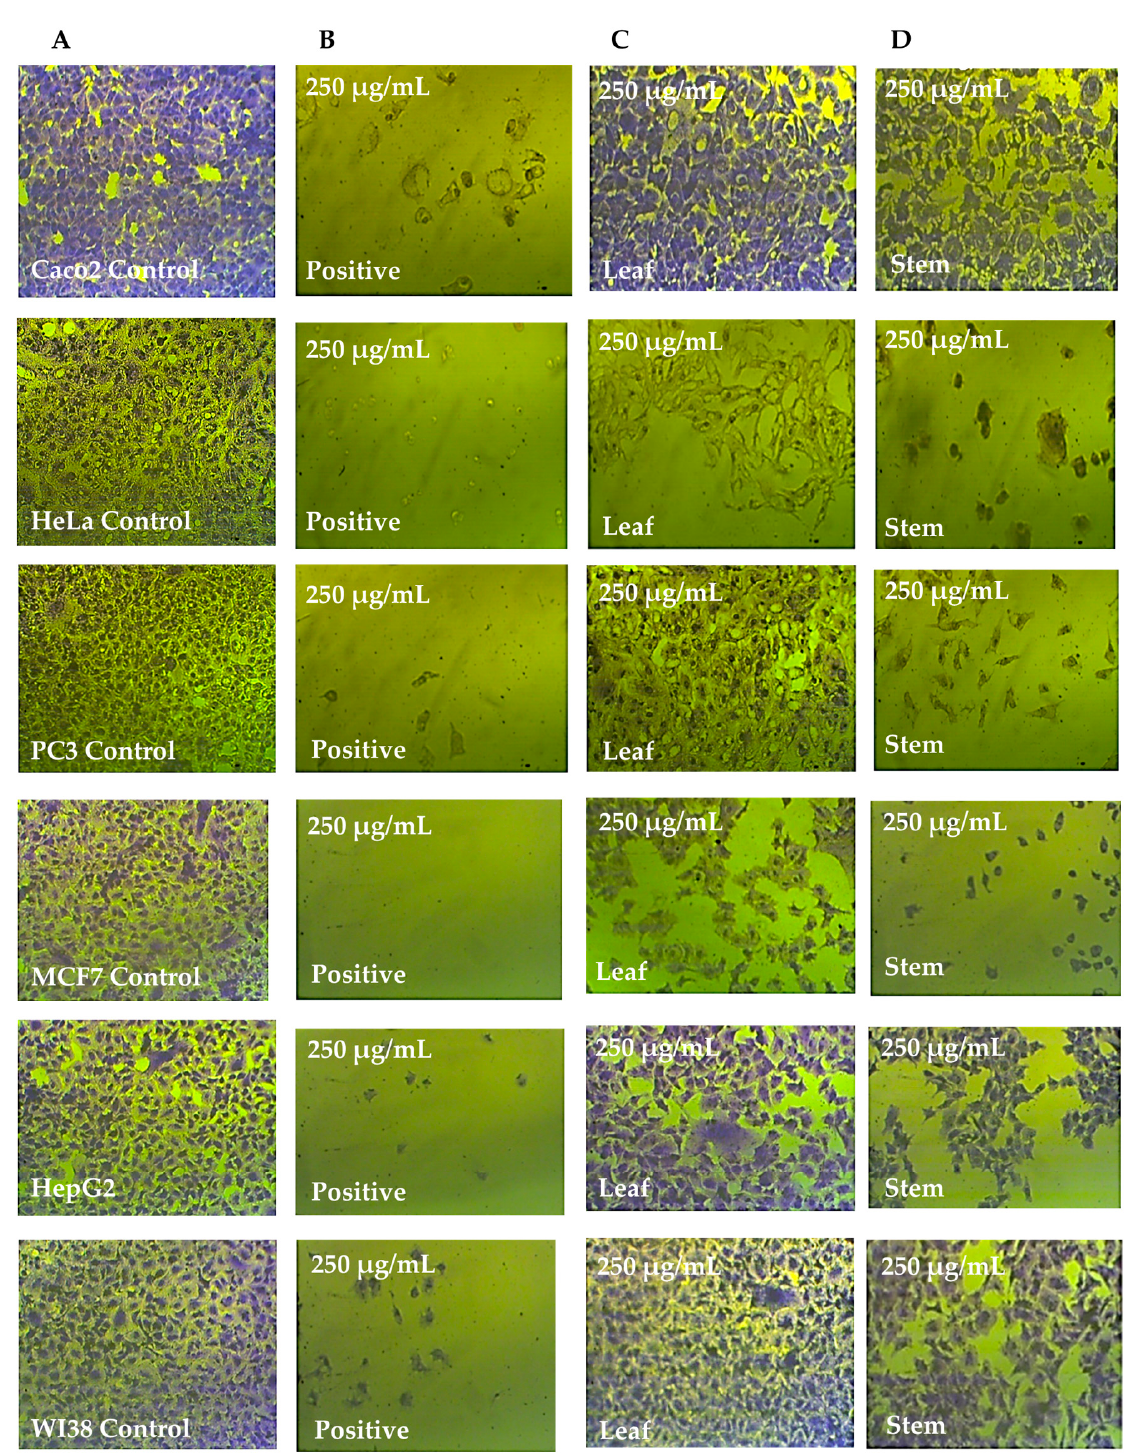
Figure 5. Anticancer effects of Calystegia silvatica leaves and stems extracts in methanol on cancer cell lines: ( A ) complete monolayer sheets are seen in all of the cancer cell lines that have not been treated; ( B ) doxorubicin treatment results in rounded and shrunk cells in all of the cancer cell lines; ( C ) shrunk cells are observed in HeLa and MCF7 cell lines treated with the extract from Calystegia silvatica leaves; however, no morphological changes are observed in Caco2, HepG2 and WI38; ( D ) the extract from Calystegia silvatica stems used to treat HeLa, PC3, MCF7 and HepG2 cancer cell lines revealed significantly rounded and shrunk cells; however, small rounded and shrunk cells are observed in Caco2 and W138.